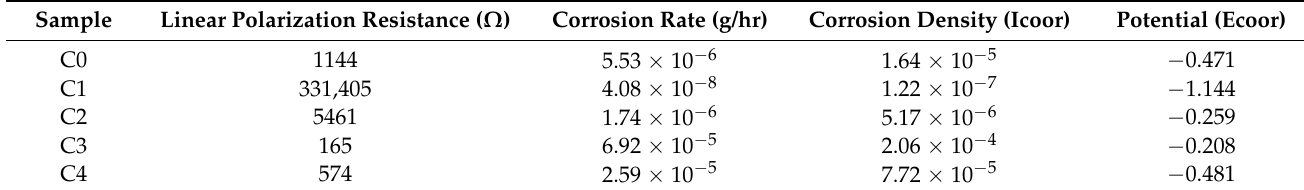
Table 3. Summary of the results from the potentiodynamic polarization